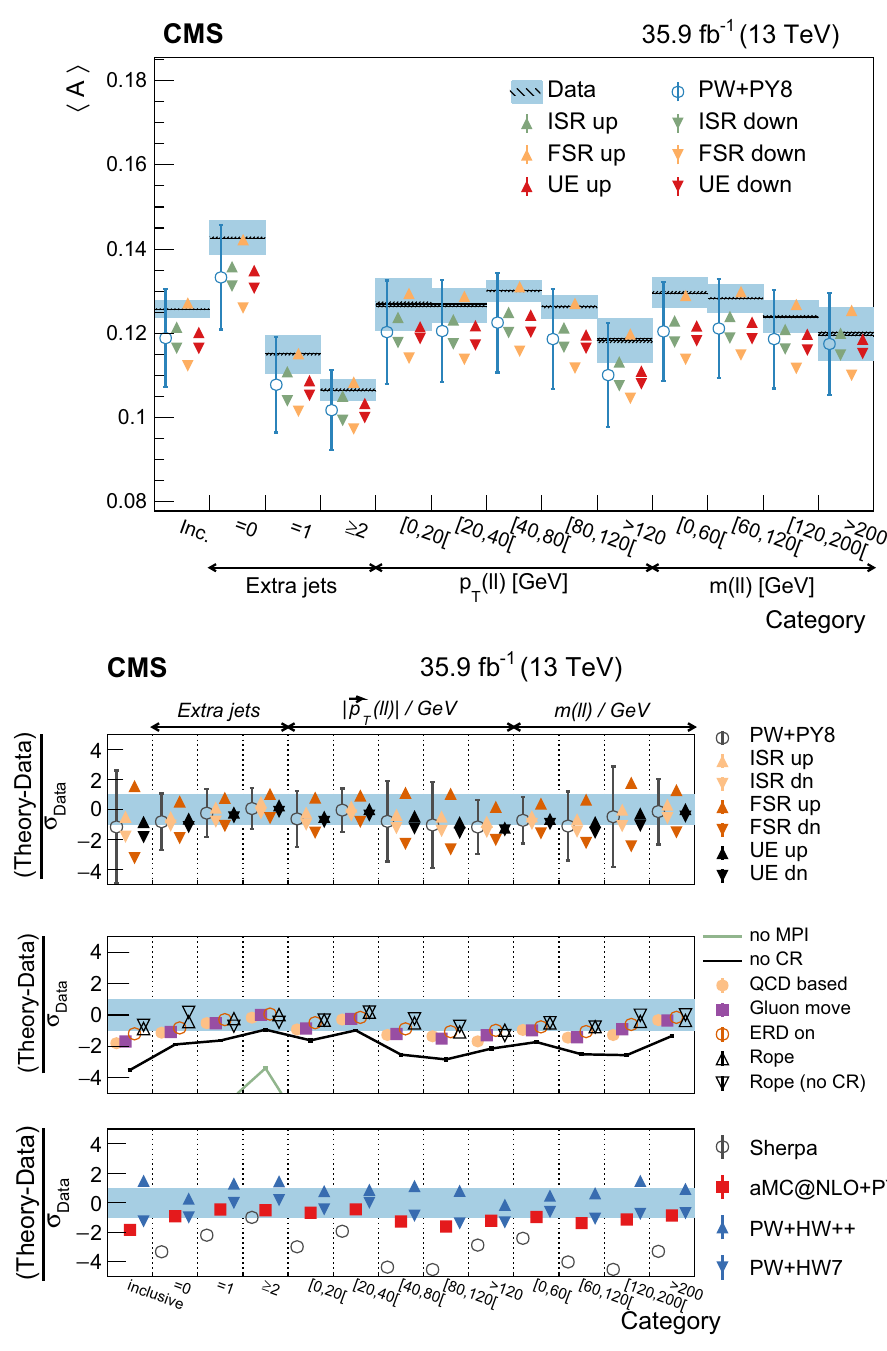
Fig. 21 Average aplanarity in different categories. The conventions of Fig. 14 are